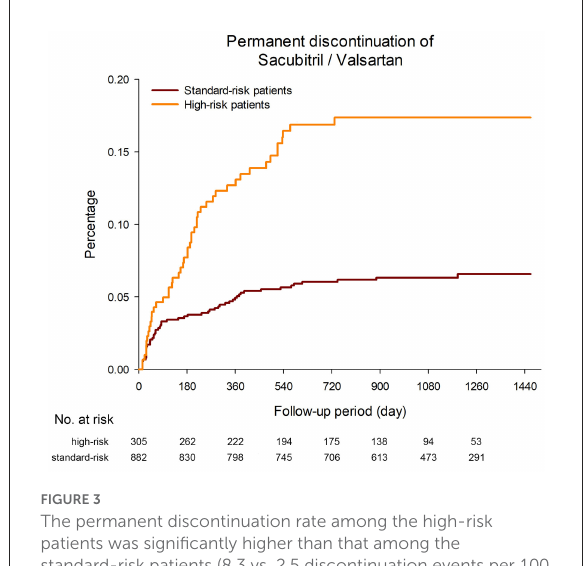
FIGURE3 The permanent discontinuation rate among the high-risk patients was significantly higher than that among the standard-risk patients (8.3 vs. 2.5 discontinuation events per 100 patient-years, p <